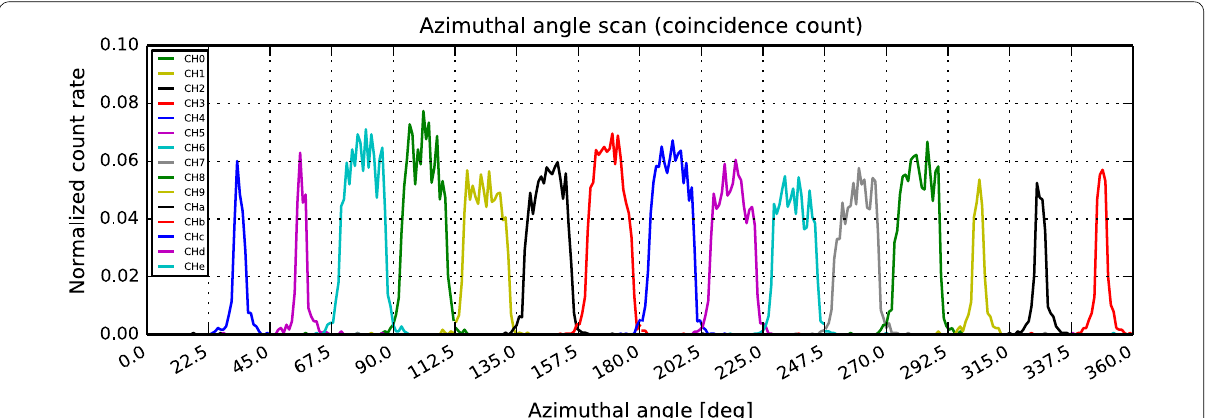
Fig. 6 Azimuthal angle response obtained in laboratory experiments. Proton beams with the energy of 12 keV are used. 0 deg and 90 deg coincide with + Y sc and + Z sc directions, respectively (see Figs. 1, 2)